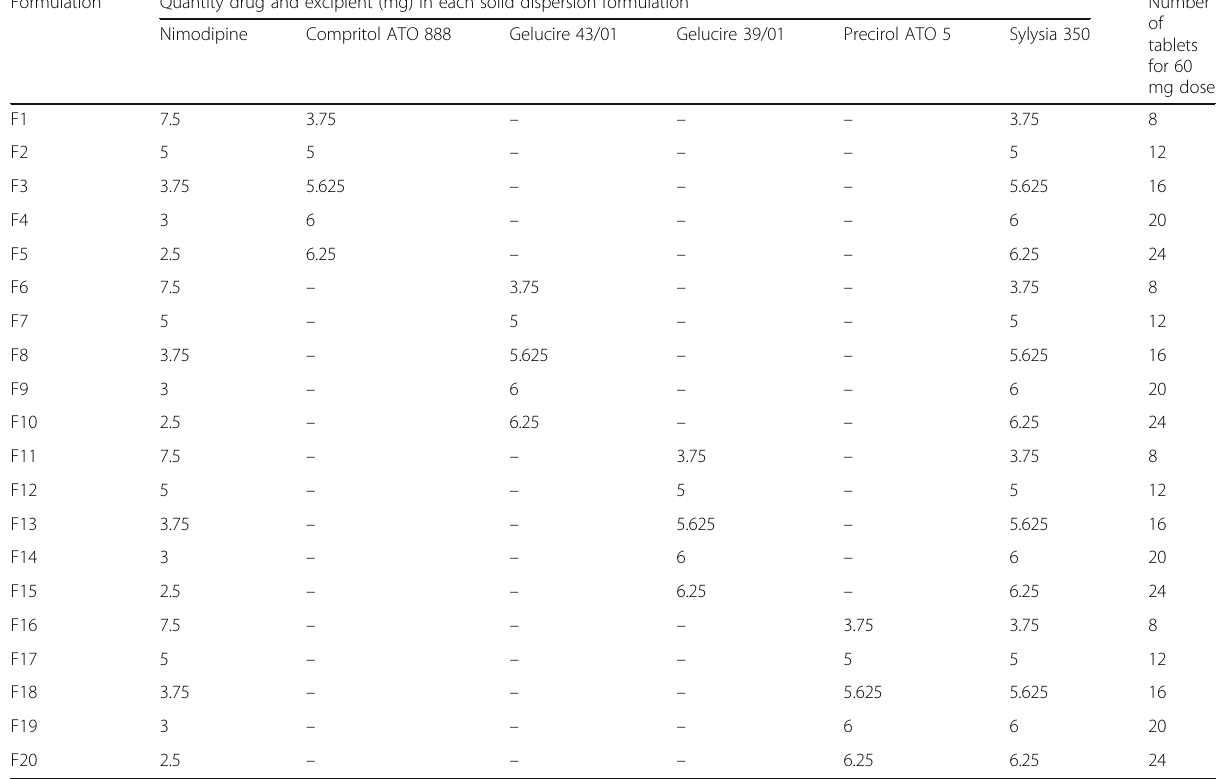
Table 2 Composition of minitablet (weight of each minitablet 15 mg)